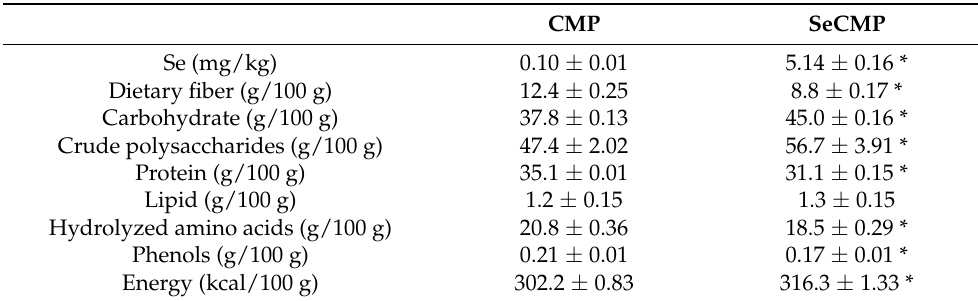
Table 1. Chemical compositions of crude polysaccharides isolated from Se-deficient C. militaris (CMP) and Se-rich C. militaris